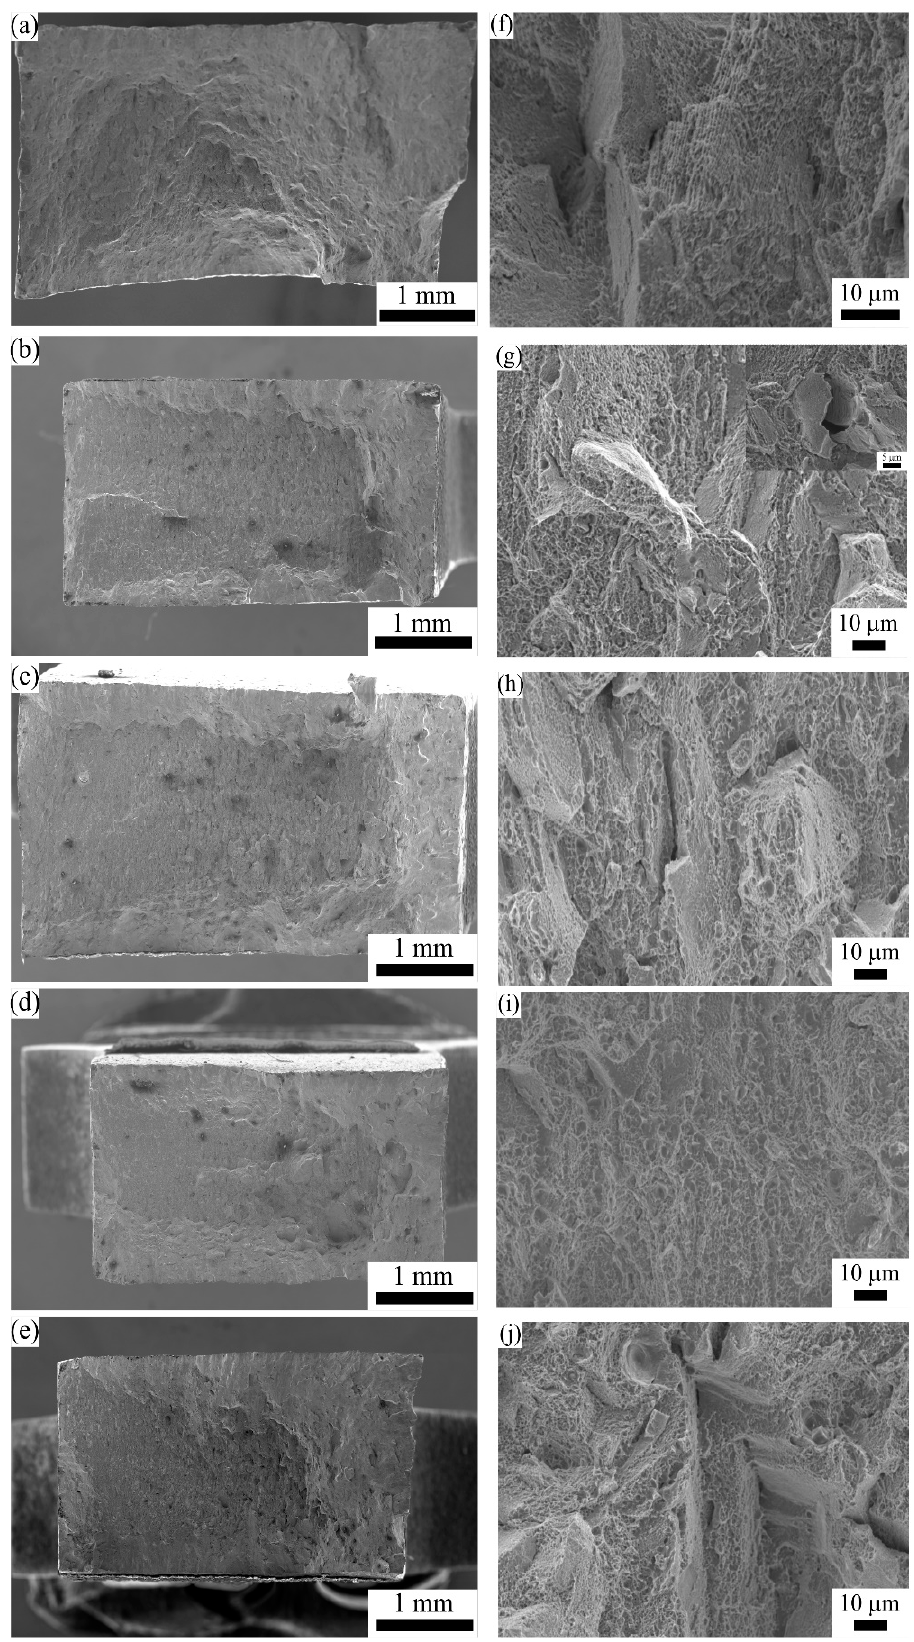
Figure 16. The tensile fracture surface of the IN 718 specimens in ( a , f ) AB, ( b , g ) HT1, ( c , h ) HT2, ( d , i ) HT3, and ( e , j ) HT4 conditions.